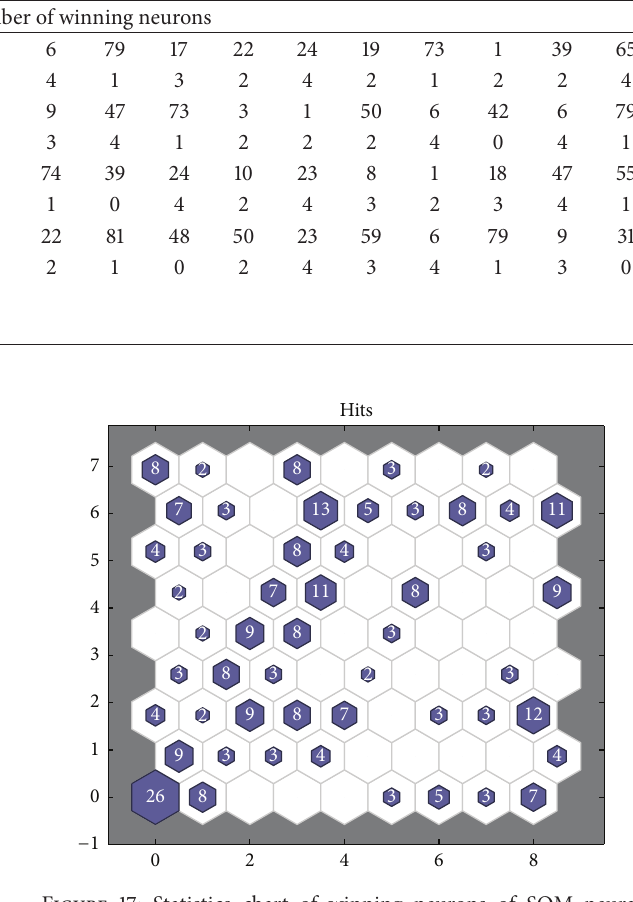
Figure 17: Statistics chart of winning neurons of SOM neural network optimized by improved PSO